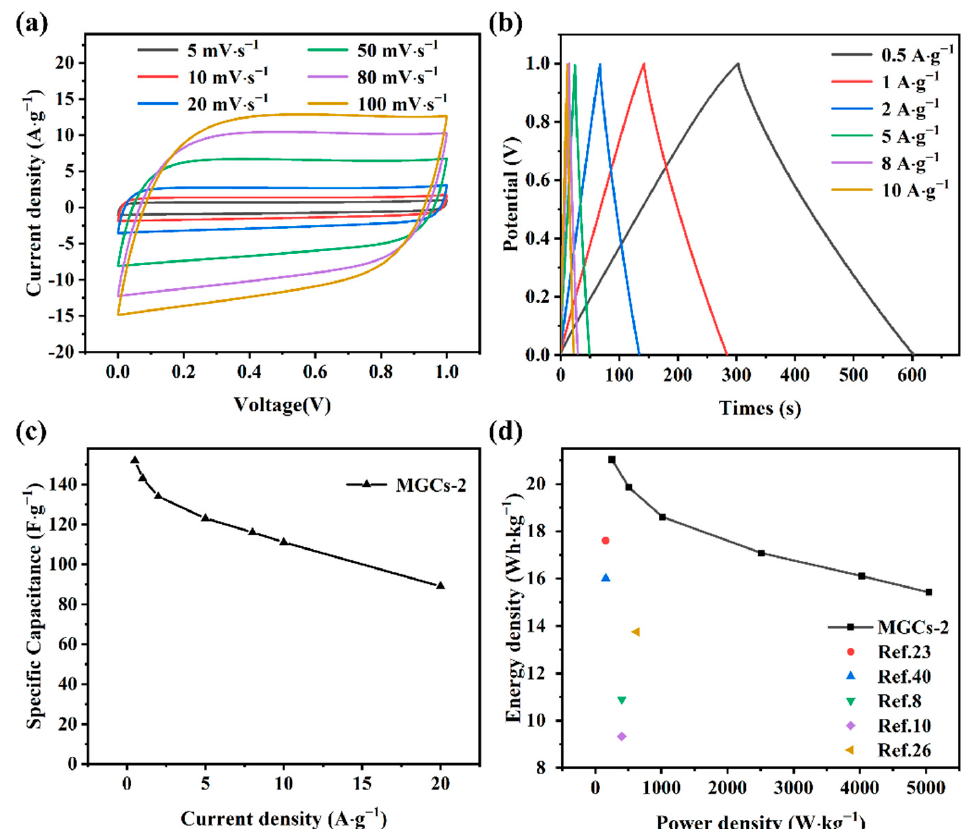
Figure 6. Electrochemical properties of SCD in 6 M KOH: ( a ) CV at various scanning rates; ( b ) GCD and ( c ) specific capacitance at different current densities; ( d ) Ragone plot.